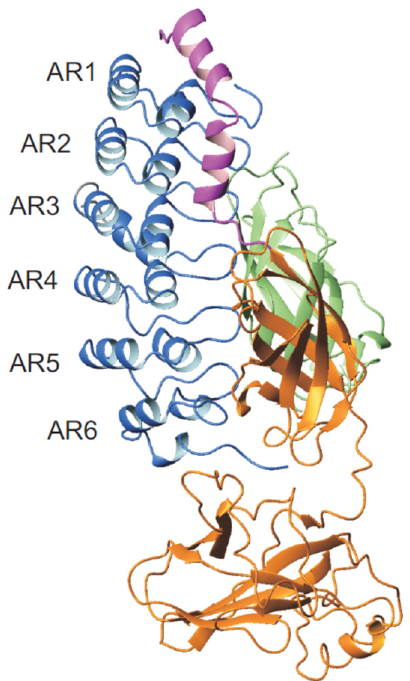
Figure 4. Structure representation of the I κ B α ankyrin domain in complex with NF- κ B. The I κ B α ankyrin domain, composed of six repeats, is illustrated in blue, p50 in green, p65 in orange, and the p65 NLS in magenta (PDB ID: 1NFI) [35] .